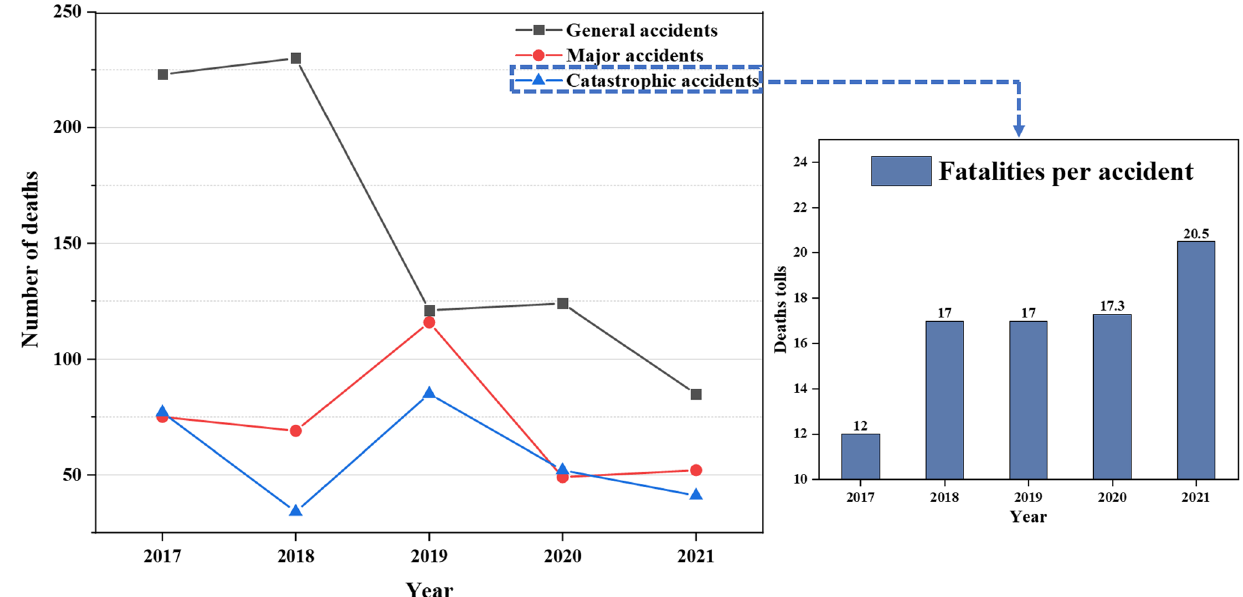
Fig. 5 Number of deaths in different accidents level and fatalities per accident in catastrophic